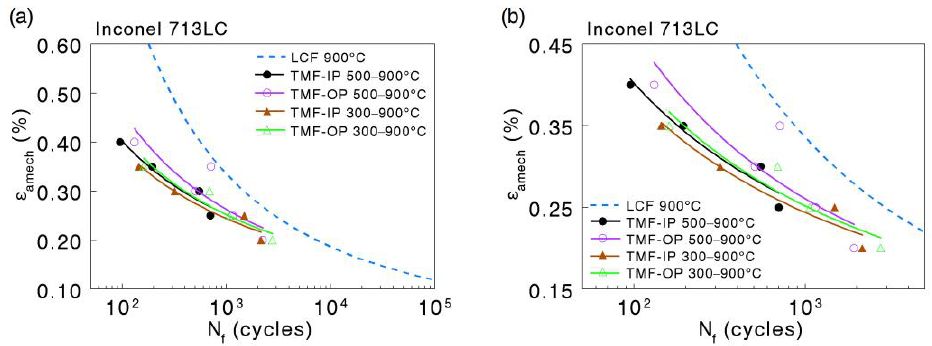
Figure 7. Fatigue life curves in the representation of the mechanical strain amplitude vs. the number of cycles to failure ( a ) overall view ( b ) detailed view focusing on TMF results. LCF data from [6].